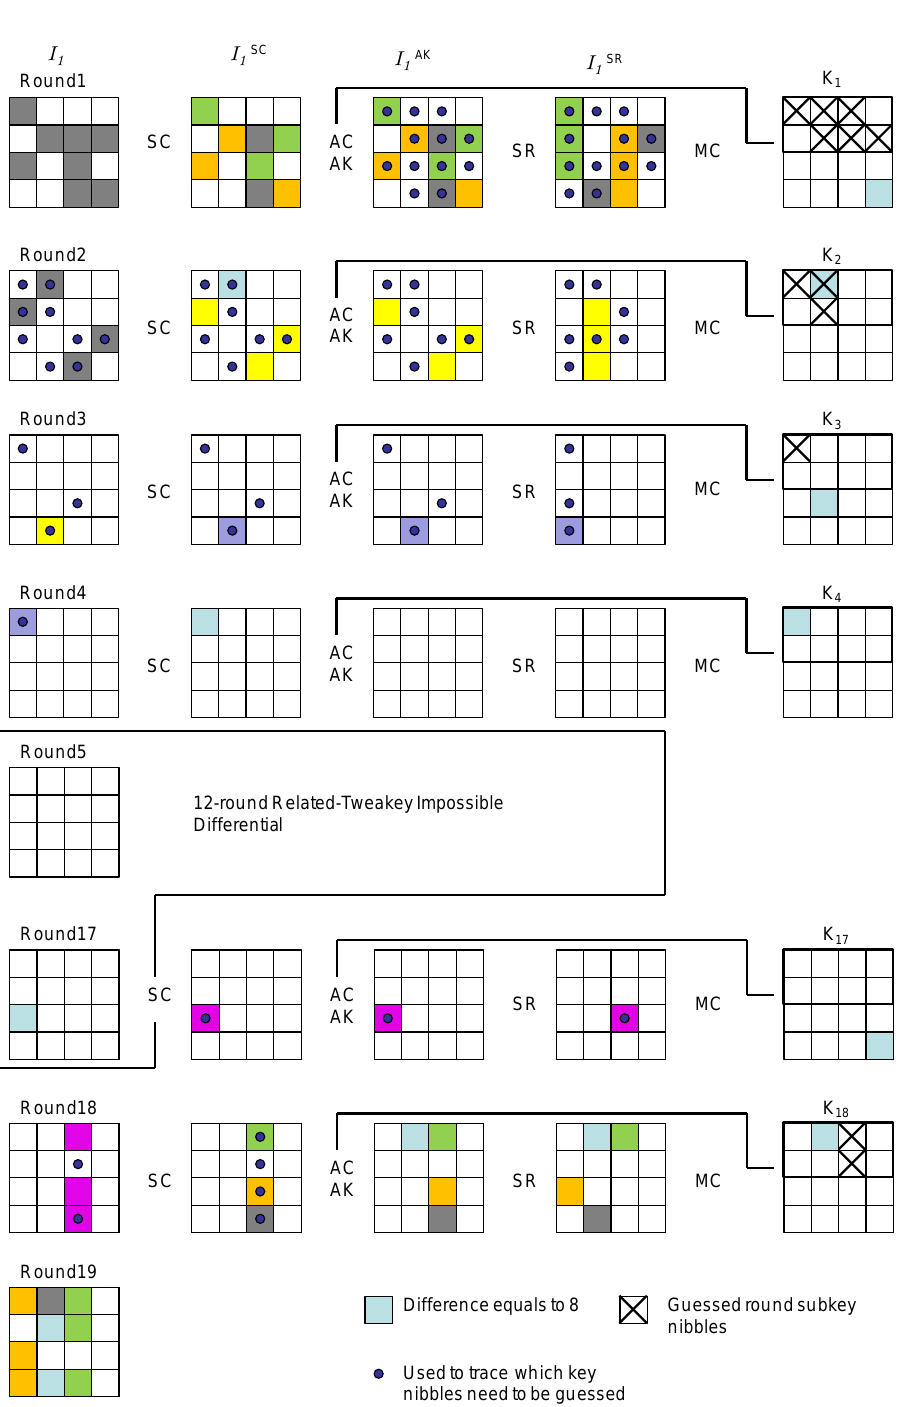
Figure 3: A relate-tweakey impossible differential attack on 18-round